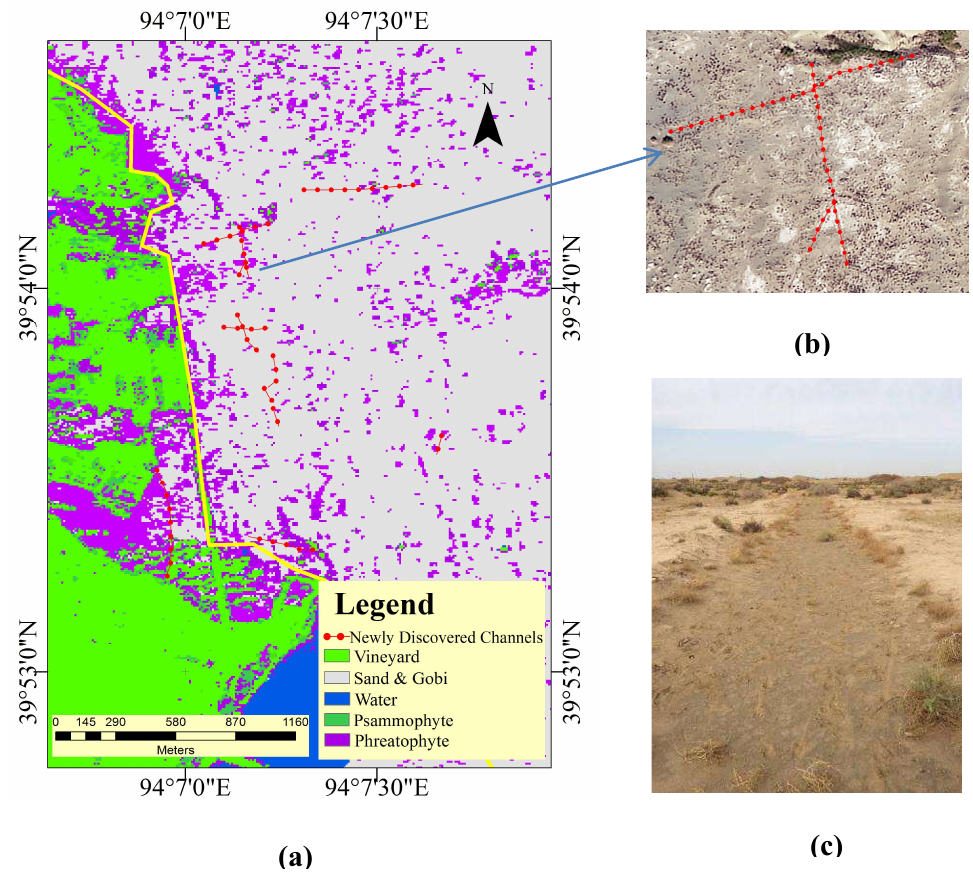
Figure 13. Images and field photos of abandoned channels located in area 1 of East Gudongtan. ( a ) The abandoned channels on the classified images; ( b ) the channels on the Gaofen-2 image; ( c ) photo of one of the abandoned